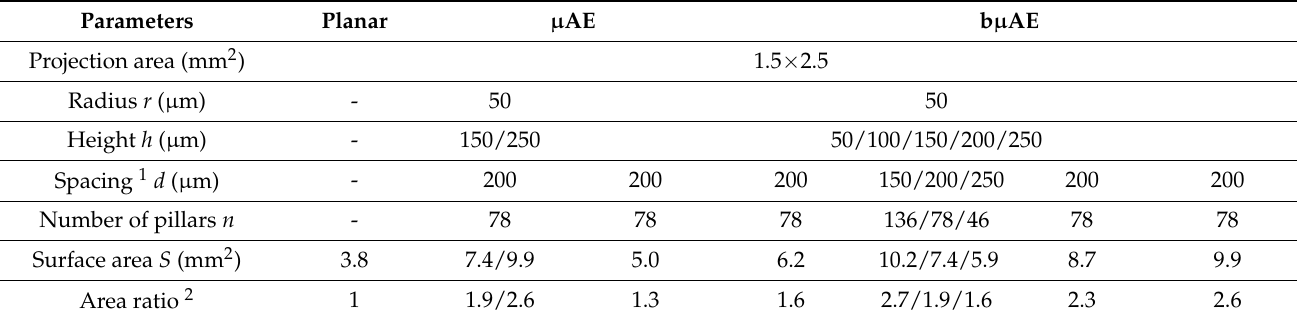
Table 1. Parameters of the b µ AEs for numerical